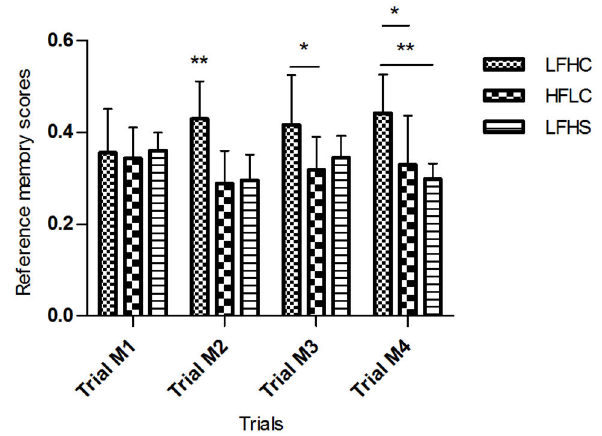
Figure 2. Reference memory performance of minipigs in the spatial hole-board discrimination test. Data are presented as mean scores for the first four trials of the memory phase (M) for low fat, high carbohydrate diet (LFHC); high fat/ cholesterol, low carbohydrate diet (HFLC) and low fat, high carbohydrate/sucrose diet (LFHS). * p < 0.05, ** p < 0.01.